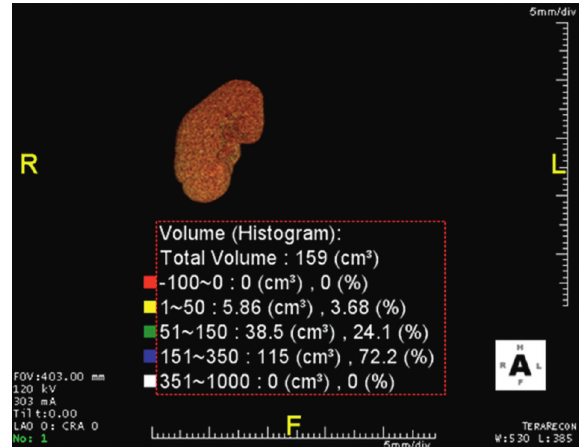
Figure 1: Reconstructed image shows right kidney volume his- togram attenuation with software.